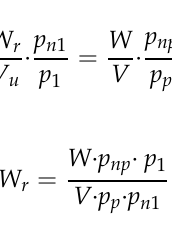
Table 3. Mean contribution of grain size classes to the mass of outburst material and the newly formed surface.